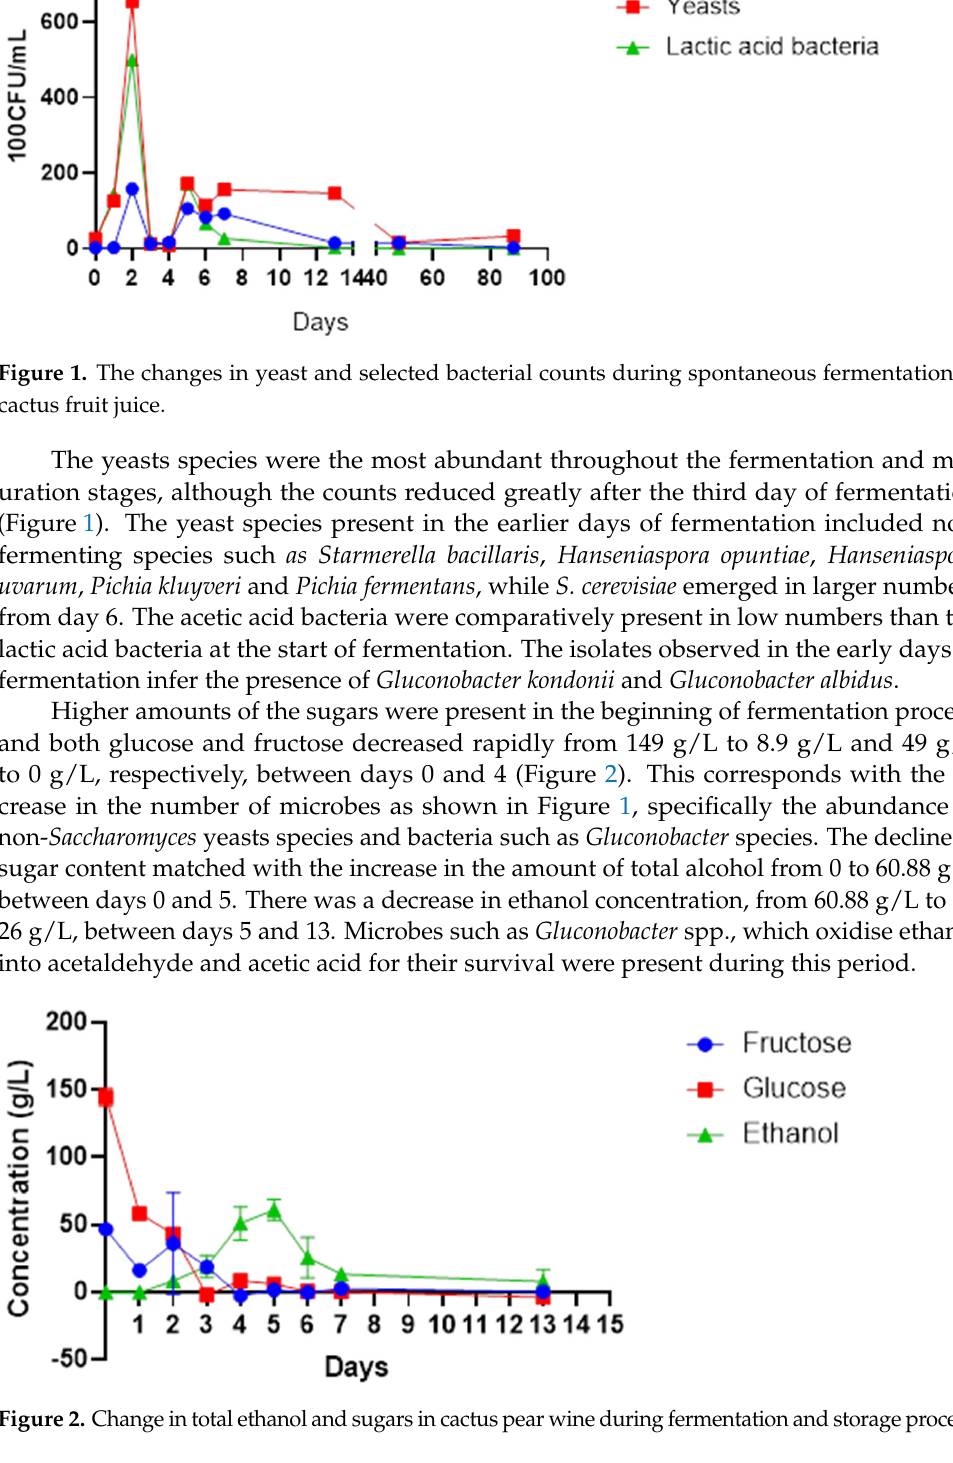
Figure 2. Change in total ethanol and sugars in cactus pear wine during fermentation and storage